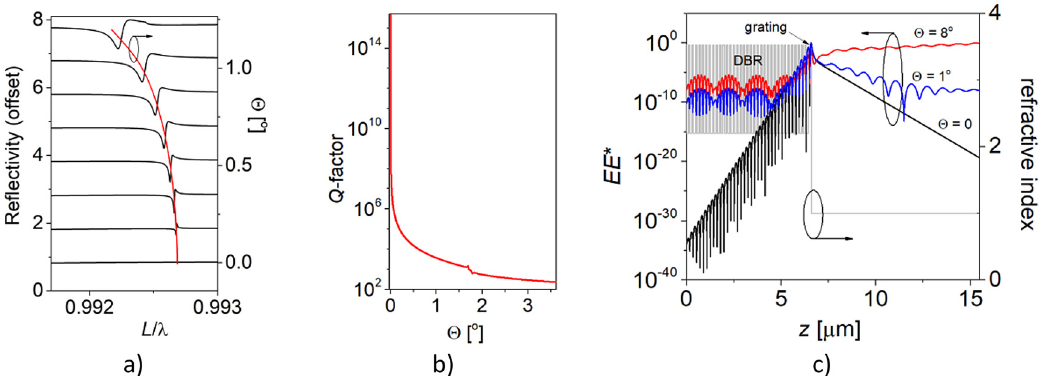
Figure 4: Reflection spectra at different incidence angles shown by black curves in a). The red curve represents the resonant wavelength of the mode indicated as (1) in Figure 3. Q -factor of mode (1) as a function of the transversal component of the wavevector k x expressed by Θ (sin Θ = k fi les along the z axis for various transversal components of the wavevector k x / k 0 ) in b). Light intensity pro different colors in c). The grey line represents the pro fi le of the refractive index along the